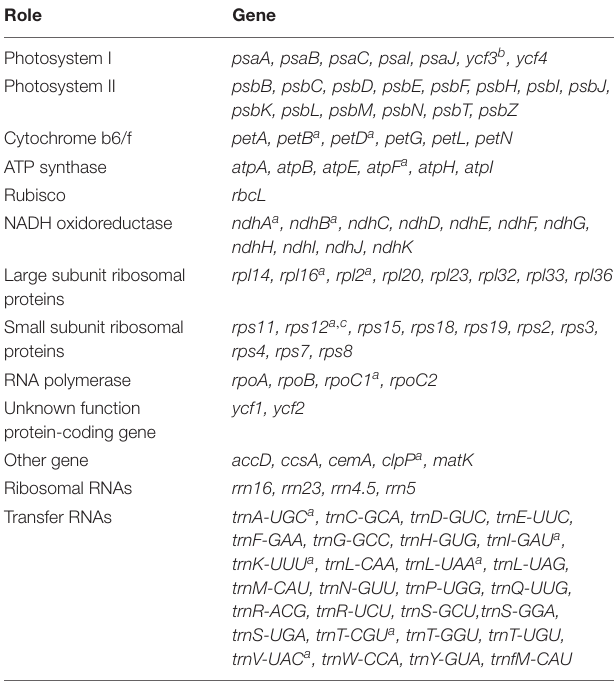
TABLE 1 | Genes present in the Vicia bungei chloroplast